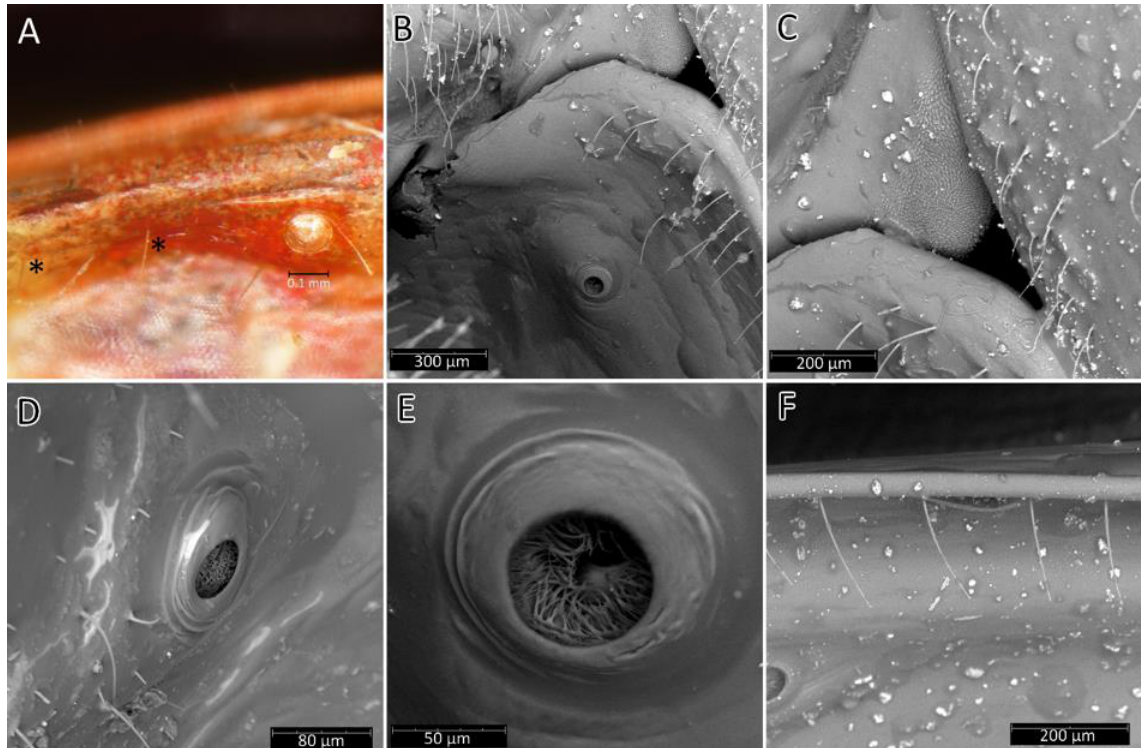
Figure 27. Phonoctonus elegans Varela, 1904: ( A ) second abdominal segment with spiracle and sensilla chaetica (marked by *), lateral view. P. luridus Miller, 1950: ( B ) contact area of thorax and abdomen, lateral view; ( C ) magnification of sensory field; ( D , E ) magnification of second abdominal spiracle; ( F ) sensilla chaetica at the lower portion of the external margin of connexiva, lateral view.